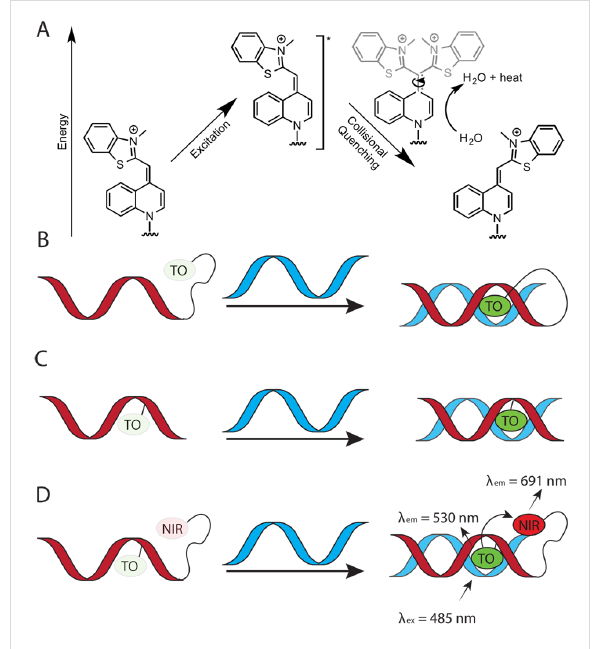
Figure 24: (A) Light-up fluorophores such as thiazole orange display fluorescence enhancement upon binding to a target oligo. In the free, single-stranded state, thiazole orange has a low fluorescence quan- tum yield as a result of collisional quenching with solvent upon excita- tion. (B) Thiazole orange can be tethered to PNA either at the terminus [151] or (C) through modified base pairs [150]. Modifying PNA at a nucleobase position with thiazole orange, typically referred to as forced intercalation (FIT) probes also results in sequence specific fluores- cence enhancement. (D) FIT probes can be coupled in a FRET system with NIR-667 dye